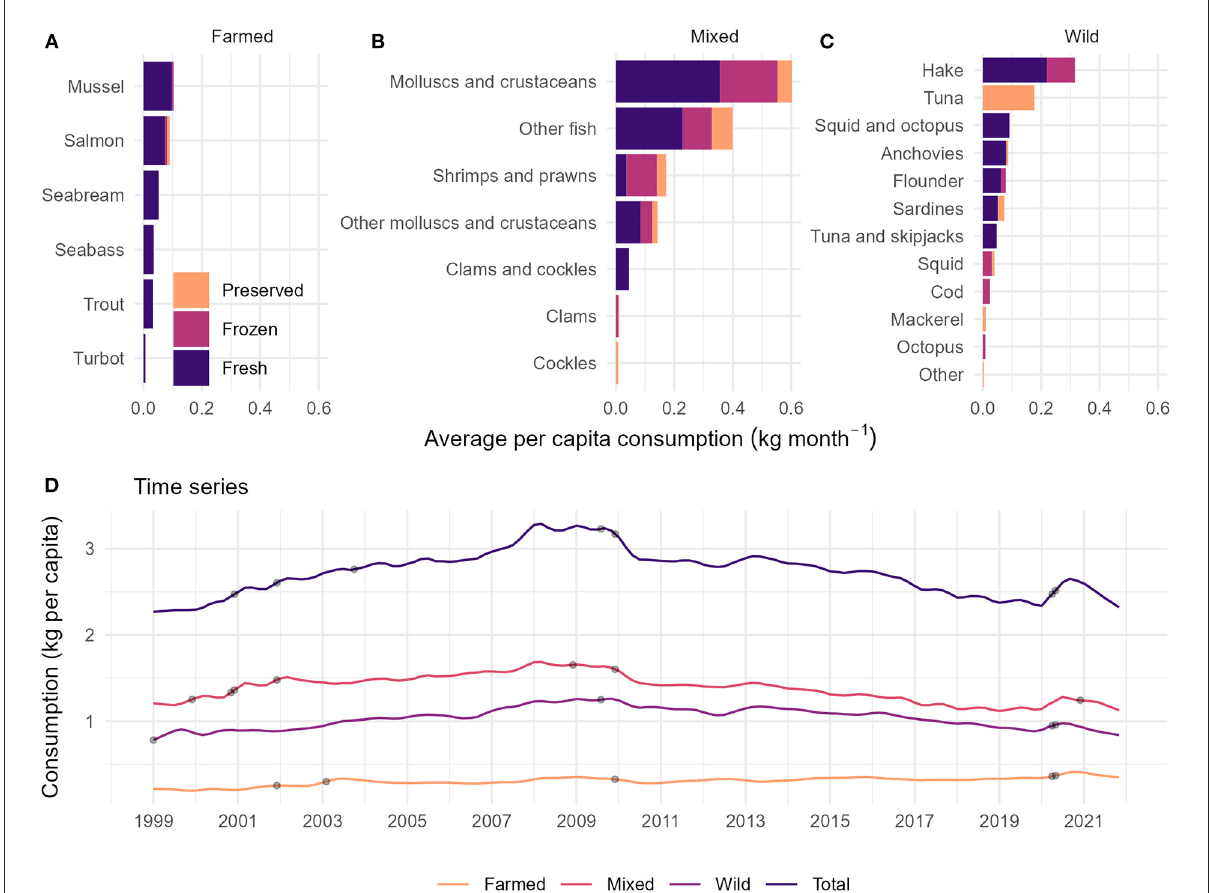
FIGURE2 Mean monthly per capita consumption of most consumed blue food groups by production source: (A) farmed, (B) mixed and (C) wild, and by type of food (fresh, frozen, and preserved), and (D) monthly time series deseasonalised temporal trends of per capita consumption. Black dots denote anomalies detected with generalised extreme studentised